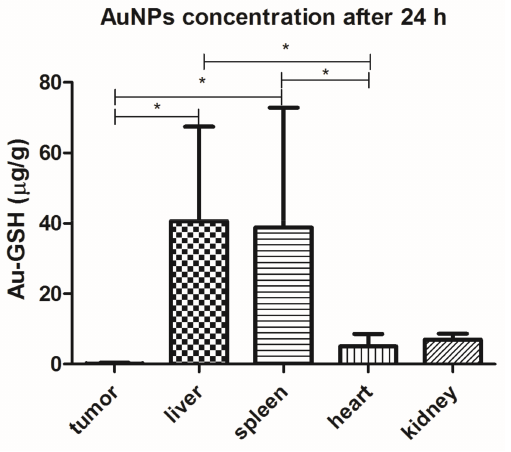
Figure 6. Au-GSH organ distribution ( µ g/g) after a single IV injection of Au-GSH in nude mice. Results are shown as the mean ± SD. ( n = 6, p ≤ 0.05 marked with *). Skin necrosis was visible at the injection site in all mice that received free Dox, mostly after the fifth or sixth intratumoral injection (Figure 7B). In the case of Au-GSH-Dox-treated mice, most of the mice (ten of twelve) did not develop visible skin necrosis (Figure 7A) and only two developed skin necrosis at the injection site after the last (sixth) intratumoral injection of the test compound. Skin necrosis was not observed in any mouse from the control group nor mice from the Au-GSH-treated group. There were no statistically important differences in the levels of creatinine and BUN, nor AST and ALT between the treated groups after six intratumoral injections of the test compounds (Figure 8).